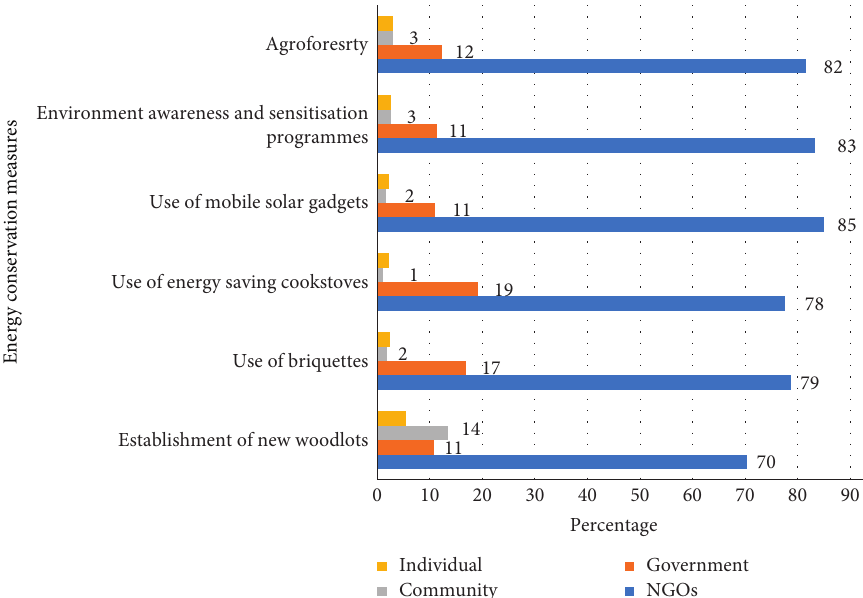
Figure 4: Wood fuel conservation measures implemented in the refugee